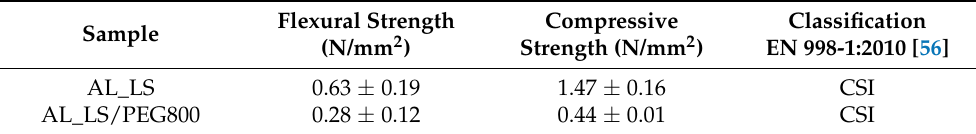
Table 7. Mechanical performance measured on aerial lime mortars with or without LS/PEG800 PCM. Classification of mortars according to EN 998-1:2010 is also